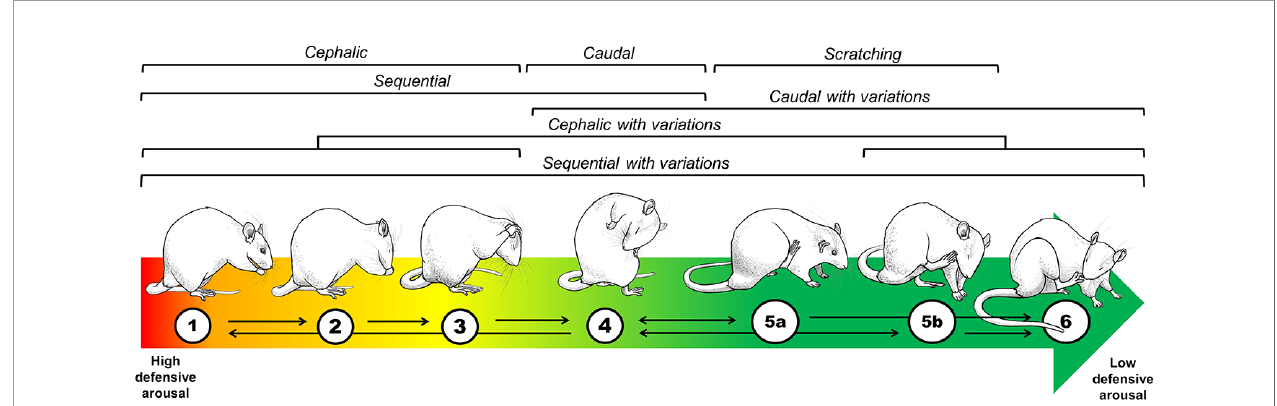
FIGURE 2 | Topographical and theoretical analysis of grooming. To understand why a non-exploratory, self-oriented behavior is displayed in the context of unconditioned anxiety tests, such as the OF, we developed a classi fi cation considering the kinetics, the anatomical distribution, and the complexity of grooming strokes (Brenes et al., 2009; Rojas-Carvajal et al., 2018; Rojas-Carvajal and Brenes, submitted). Based on its anatomical distribution, grooming was classi fi ed as cephalic (1 – 3), caudal (4), and sequential (1 – 4). Based on its motor complexity, each anatomical category could also include variations as follows: cephalic (1 – 3 + 5b, 6), caudal (4 + 5a, 6) and sequential (1 – 4 + 5a, 5b, 6). Regarding the kinetics, the colored arrow represents the theoretical association between grooming subtypes and defensiveness over time. The red-to-green fading indicates the transition from high defensive arousal to low defensive arousal, with cephalic subtypes appearing at the beginning of testing when exploratory and risk- assessment behaviors are prominent (Brenes et al., 2009; Rojas-Carvajal et al., 2018). With time, sequential grooming with variations gradually appears. As complex and intricate grooming sequences seem to compromise the prompt responses to any oncoming threat, it supposes that rats are now disengaged from displaying defensive responses. Thus, we interpreted the appearance of those subtypes as markers of habituation learning and emotional de-arousal (Brenes et al., 2009; Rojas-Carvajal et al., 2018). Black arrows represent the most common transition between the grooming